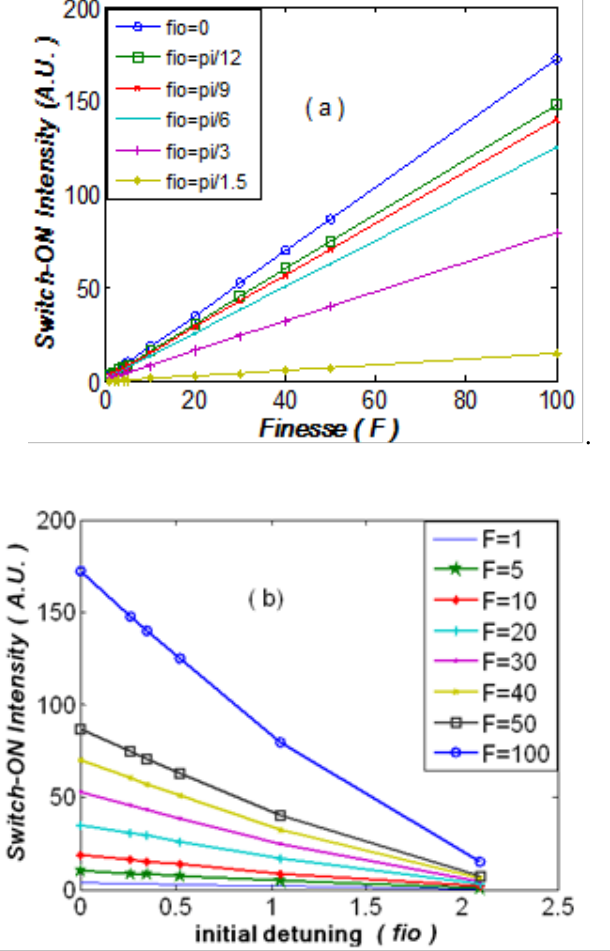
Fig.6: (a) The relation between etalon finesse value and switch-ON intensity for different values of initial detuning. (b) The relation between the etalon initial detuning and the switch-ON intensity for different etalon Finesse